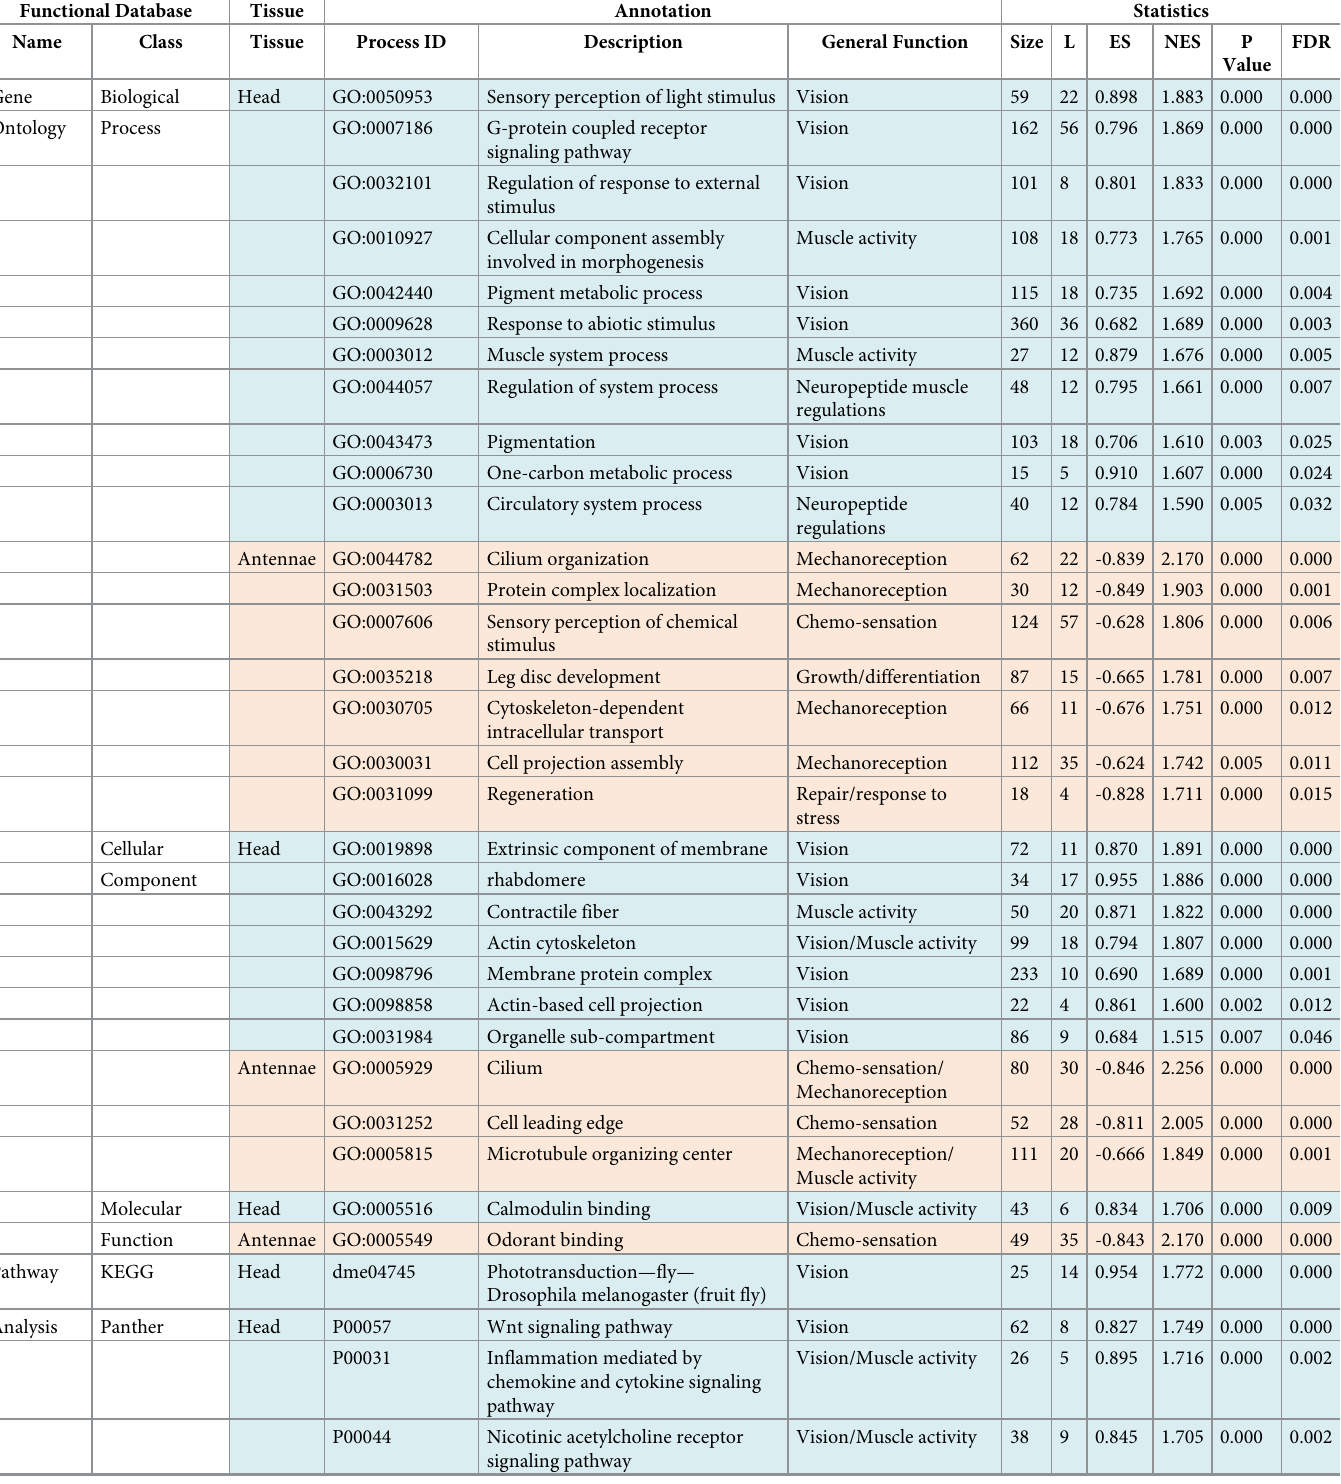
Table 1. Summary of Canonical Gene-set Enrichment Analysis (GSEA) of differentially expressed transcripts between male G . m . morsitans tsetse fly antennae and head transcriptomes. Functional